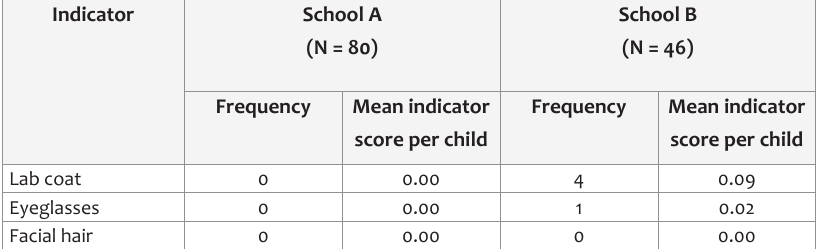
Table 3: Frequency and mean indicator scores